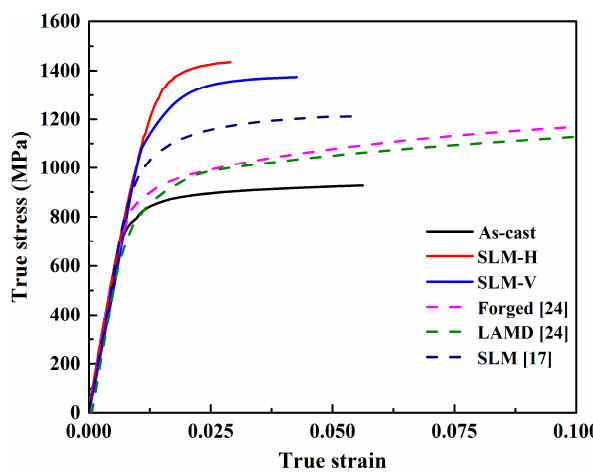
Figure 5. The quasi-static stress-strain curves comparison among the SLMed, the 3D laser deposited, Figure 5. The quasi ‐ static stress ‐ strain curves comparison among the SLMed, the 3D laser deposited, and the conventional Ti–6Al–4V and the conventional Ti–6Al–4V alloy.